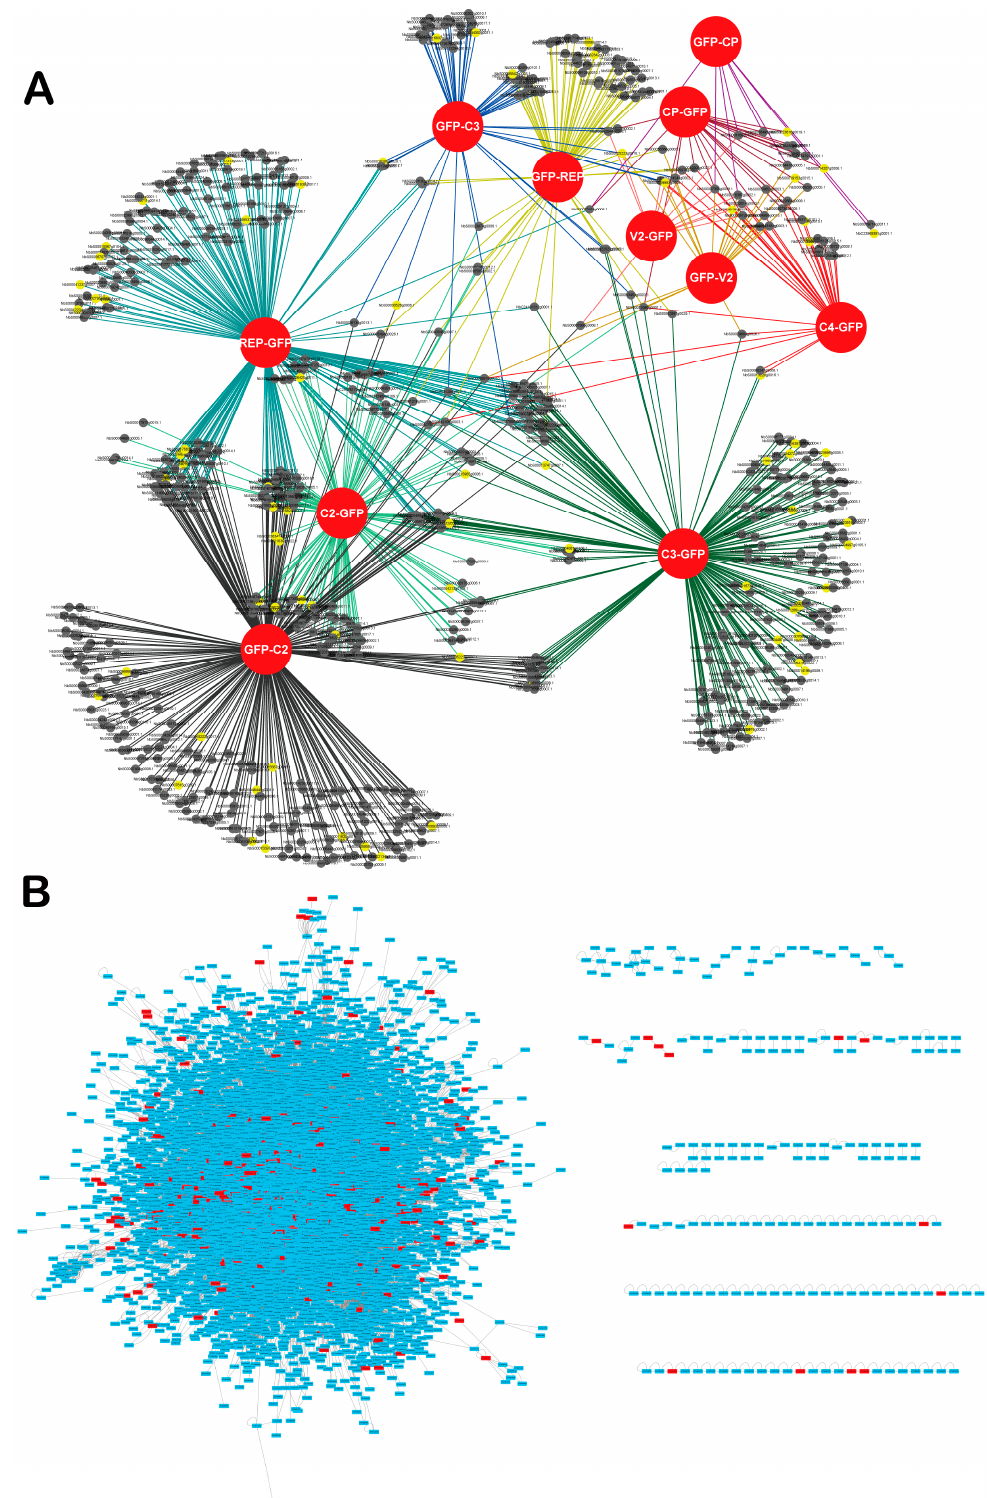
Figure 2. Network of TYLCV- N. benthamiana protein-protein interactions. ( A ) Network representation of TYLCV- N. benthamiana protein-protein interactions. Viral proteins (fused to GFP) are depicted as red circles. Best hits of Arabidopsis proteins identified as hubs in the Arabidopsis interactome are depicted as yellow nodes; non-hub proteins are depicted as black nodes. Lines (edges) indicate interactions between viral and host proteins. ( B ) Contextualization of the Arabidopsis best hits of the N. benthamiana interactors of TYLCV proteins in the Arabidopsis interactome. Best hits are depicted in red.